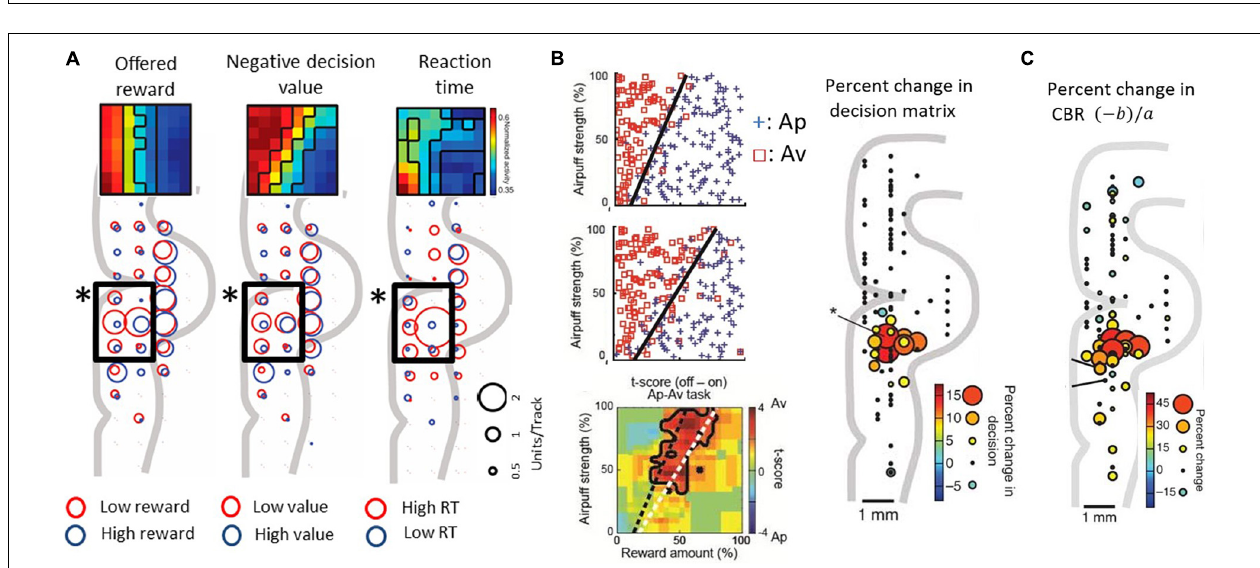
FIGURE 2 | Decision-making task with approach-avoidance conflict. (A) When reward and punishment are combined, “motivation for approach” and “motivation for avoidance” become incompatible and conflict occurs. (B) Visual stimulus. The length of the upper bar indicates the reward amount, and the length of the lower bar indicates the strength of punishment (air-puff). Macaque monkeys make decisions to accept or reject the combination. (C) An example of a monkey’s decision-making. The desire to approach “I want a reward” and the desire to avoid “I want to avoid punishment” make a conflict when reward and punishment are combined. The parameters of the discrete selection model are determined based on the monkey’s actual decision-making pattern.